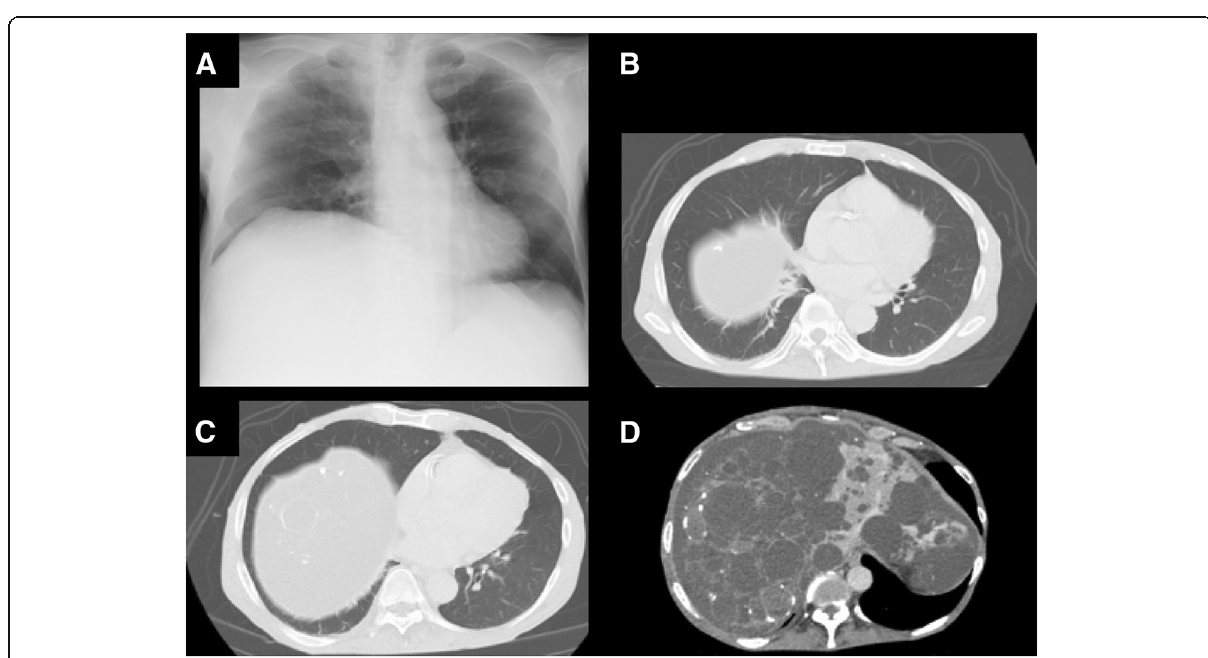
Fig. 1 Preoperative chest X-ray and computed tomographic (CT) images of a 66-year-old man with multiple liver cysts. a Chest X-ray showed an elevation of right diaphragm. b – d CT showed hepatomegaly with multiple liver cysts and no cystic legions in the bottom of both sides of